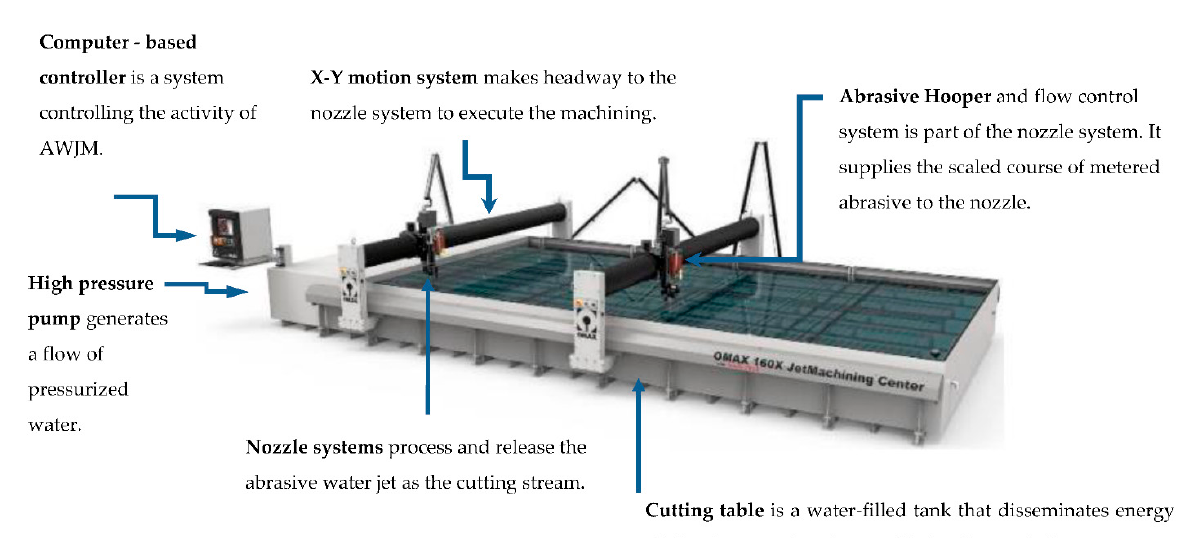
Figure 1. AWJM mechanism and components [5].